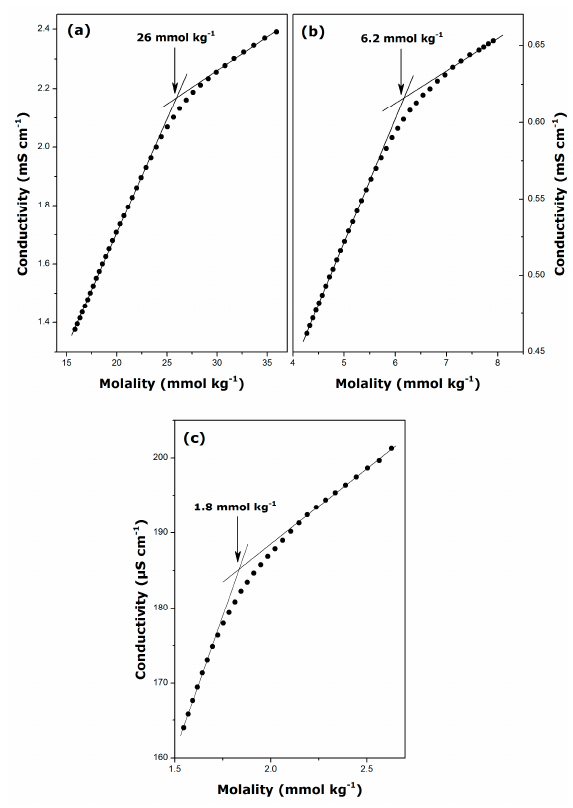
Figure 4. Plots of the specific conductance against bulk concentration for aqueous solutions of guanidinium cationic surfactants: ( a ) DGC at 298 K; ( b ) DDGC at 298 K; and ( c ) TDGC at 306 K.